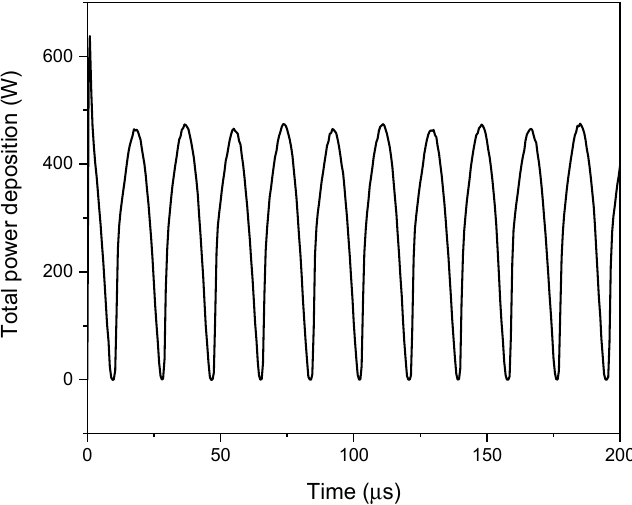
Figure 10. Time evolution of the total power distribution at x = 0.2 mm (the center of the gap).